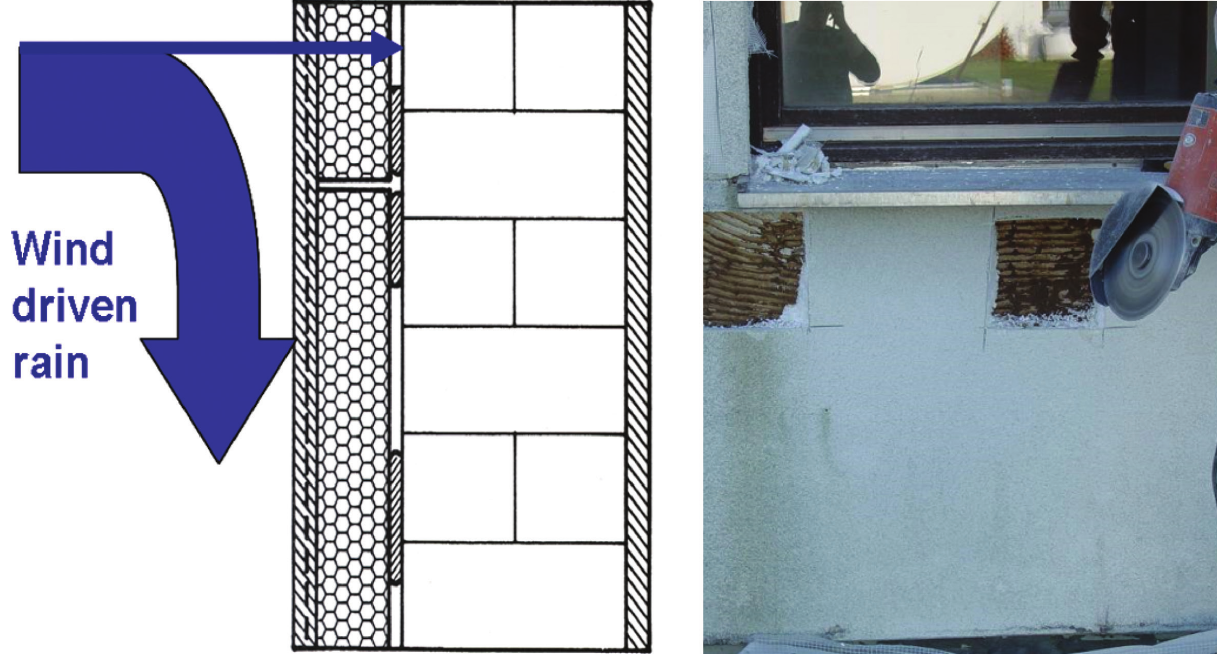
Exposed wall example showing the most likely deposit location for rainwater penetrating through leaks at windows and other connections of masonry with an external wall insulation system (left). The result of such leaks can be observed in the photo on the right-hand side. While probing the external insulation of a masonry wall underneath west-oriented windows, the living space of ants appeared behind the EPS slabs, demonstrating that the ants appreciate the warm and moist environment in the gap between the EPS insulation and the